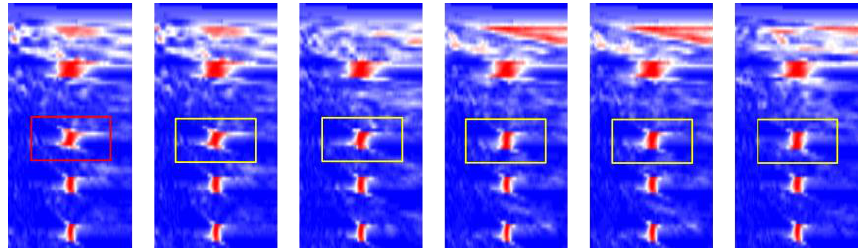
Figure 9. The tracking results of CDP 50 to CDP 55.